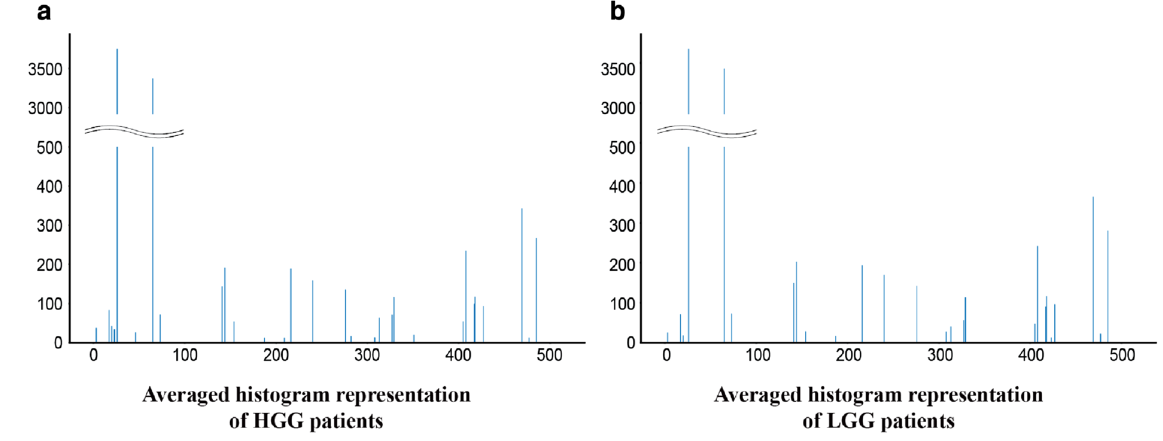
Figure 3. Average histogram representation for patients with ( a ) HGG and ( b ) LGG.